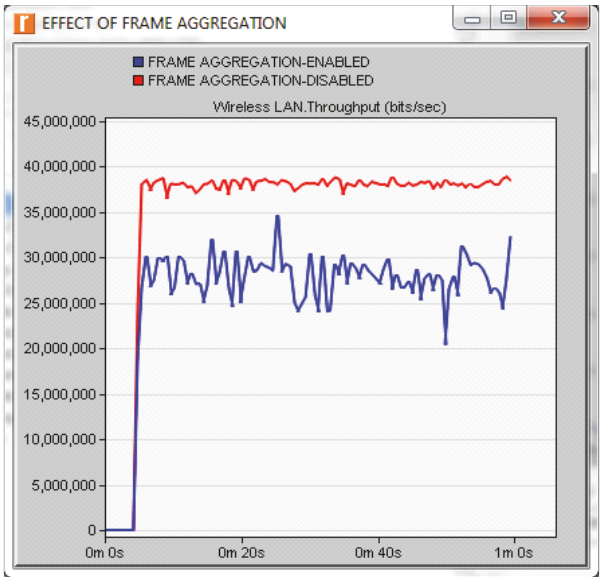
Figure 40: WLAN throughput with and without RTS and fragmen- tation mechanisms.